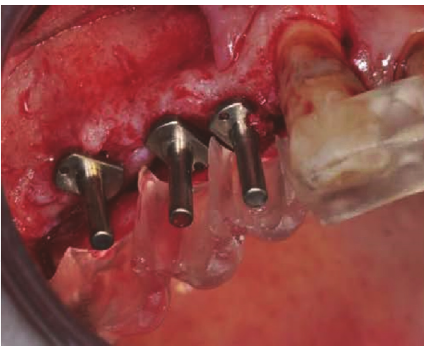
Figure 11: Inserted pins.